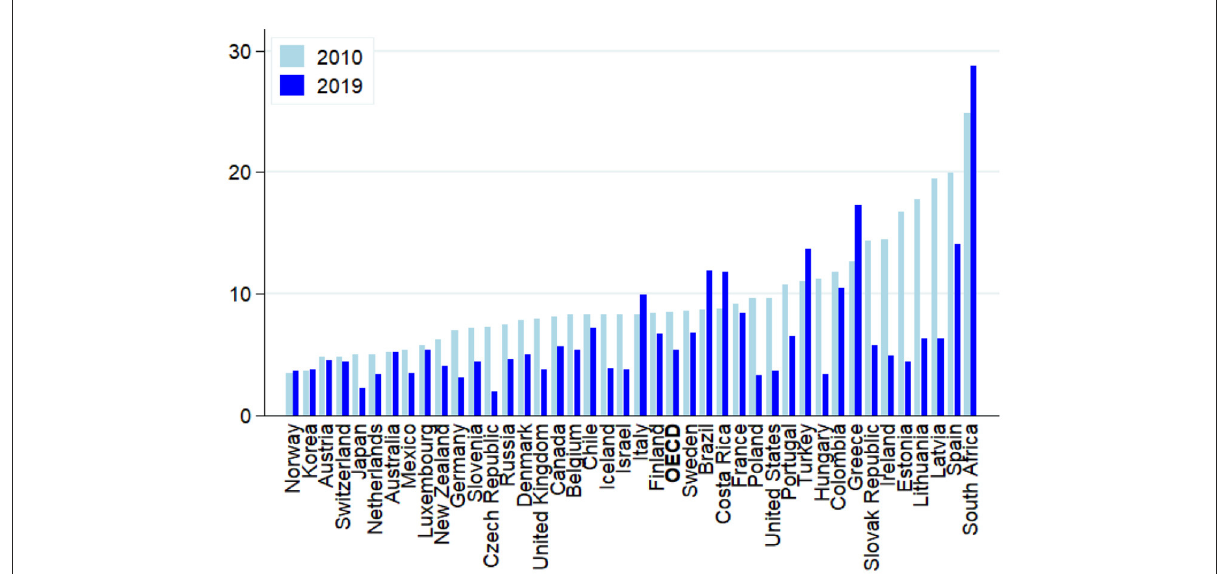
FIGURE1 Evolution of unemployment: OECD and selected G20 countries (2010 vs. 2019; in per cent of total labor force). Source: OECD, Stats